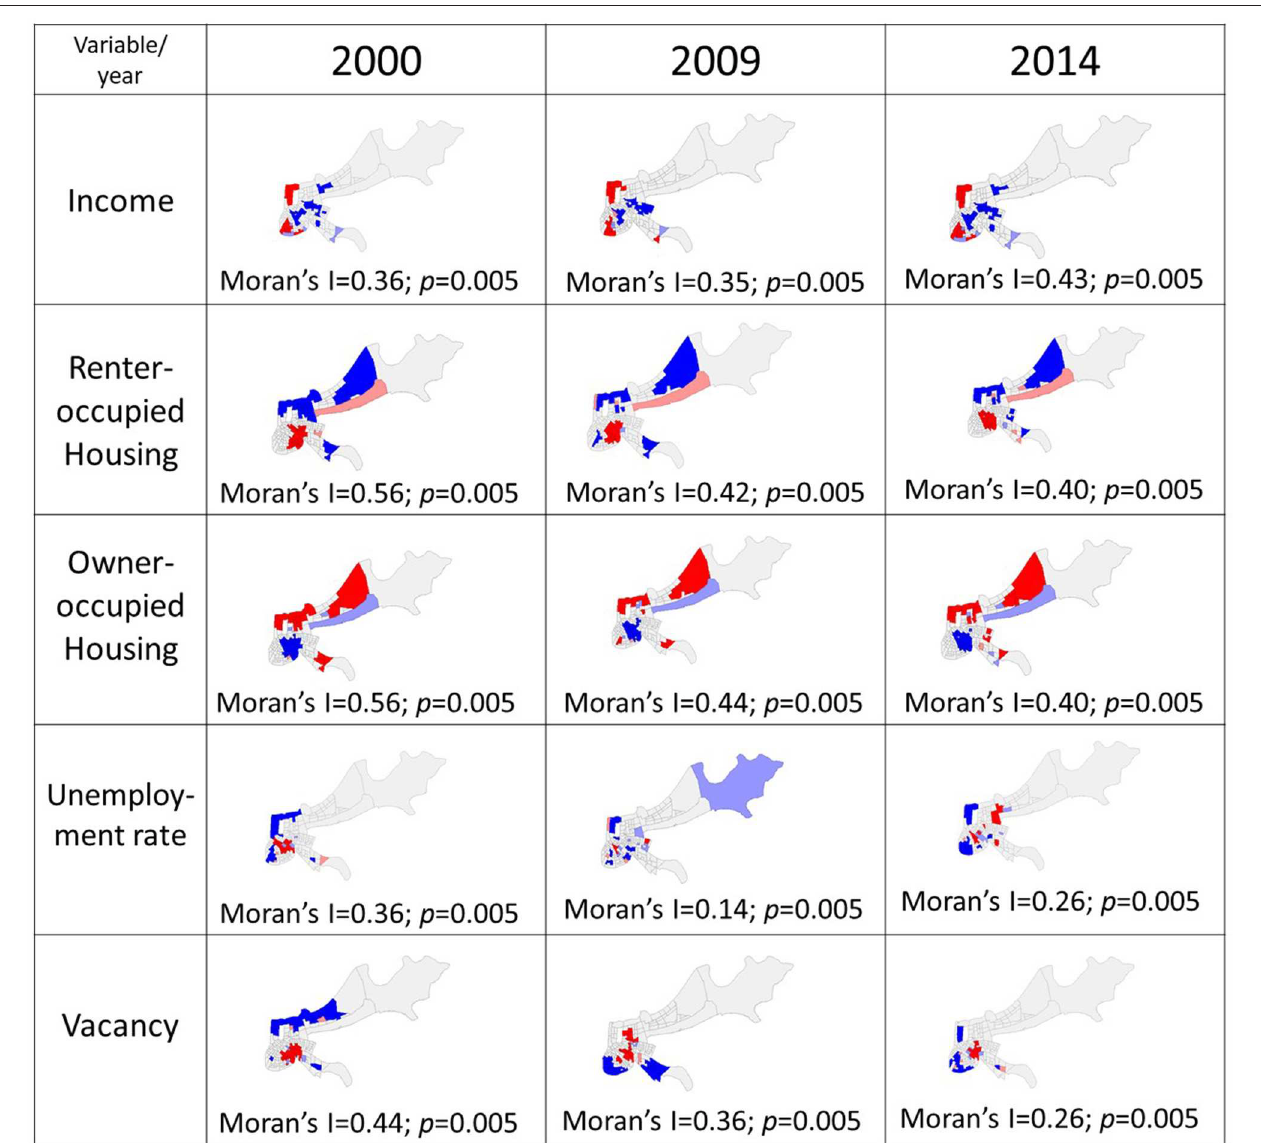
FIGURE 4 | Cluster maps and Moran’s Index of income, housing characteristics, unemployment, and vacancy. Areas in dark blue are the clusters of low value, and areas in red are the clusters of high value. The values relate to high or low income, unemployment rate, etc.